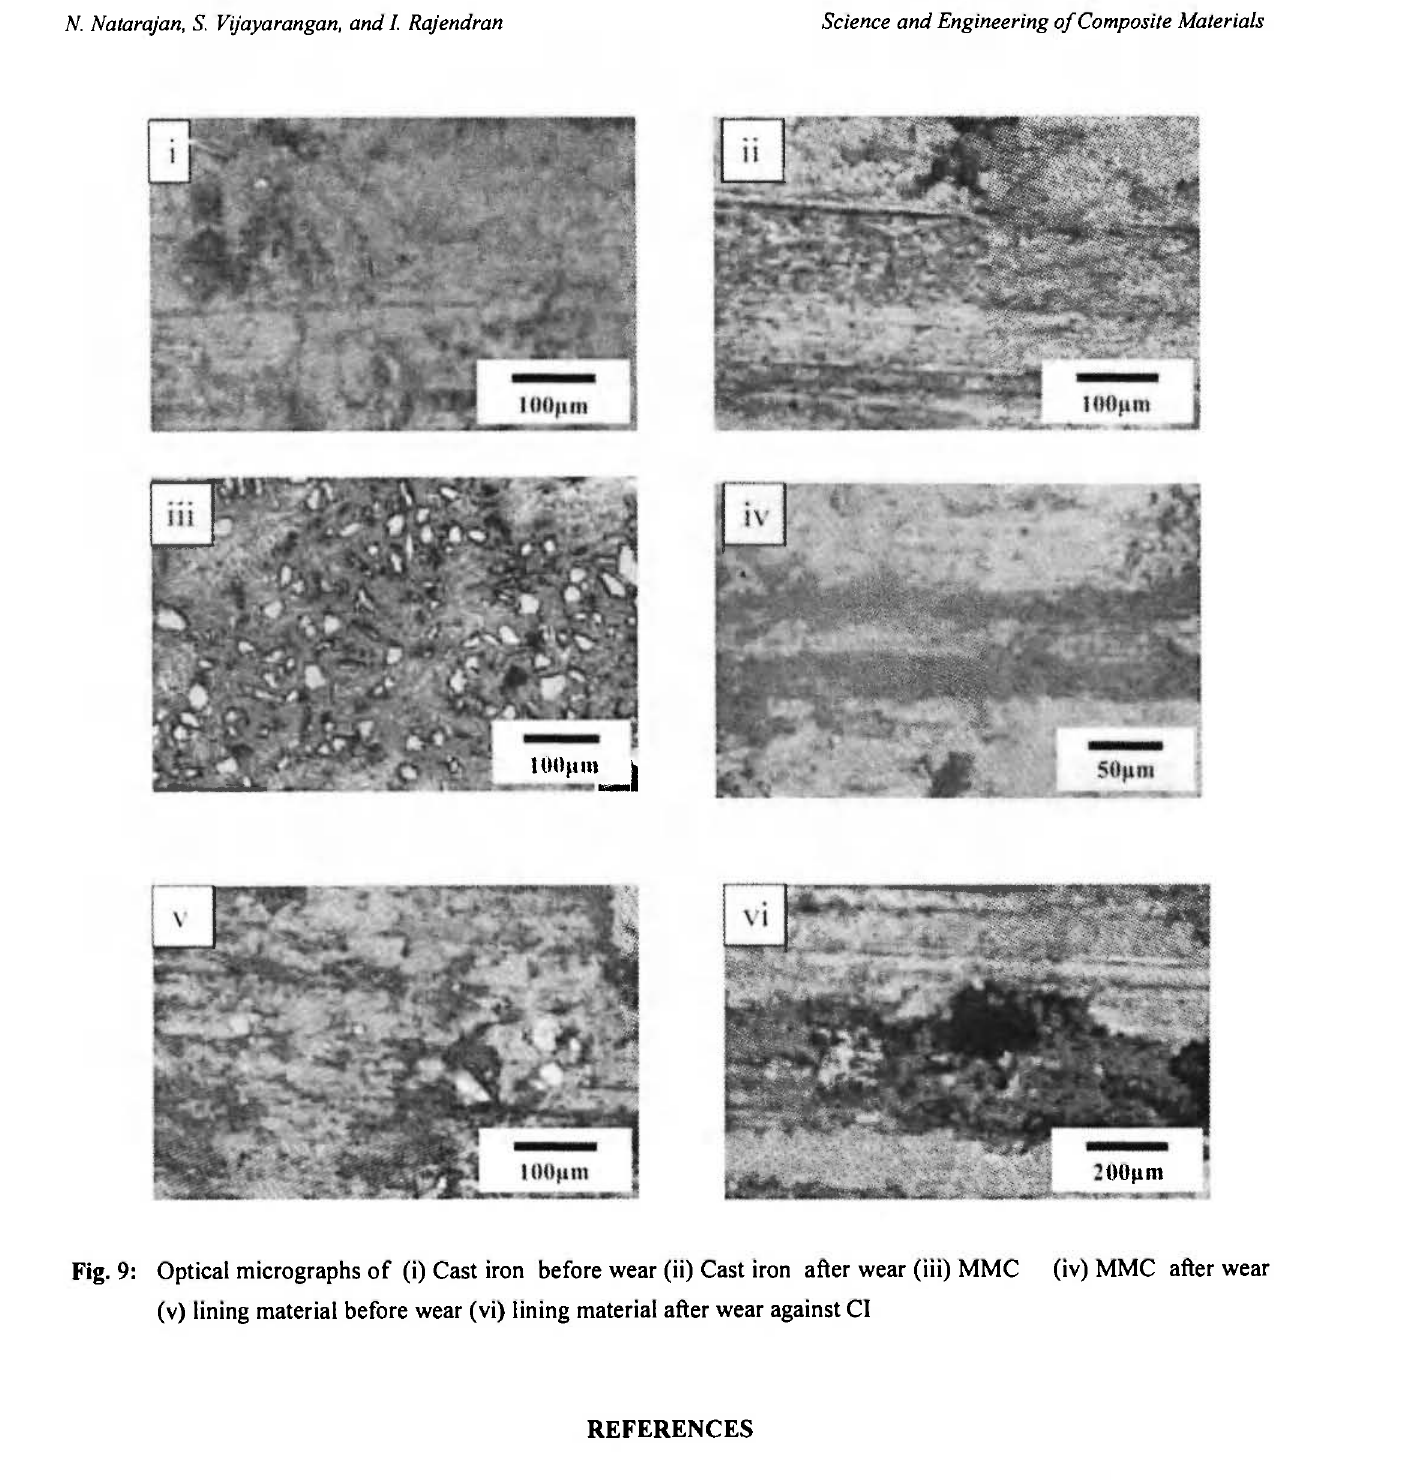
Fig. 9: Optical micrographs of (i) Cast iron before wear (ii) Cast iron after wear (iii) MMC (iv) MMC after wear (v) lining material before wear (vi) lining material after wear against